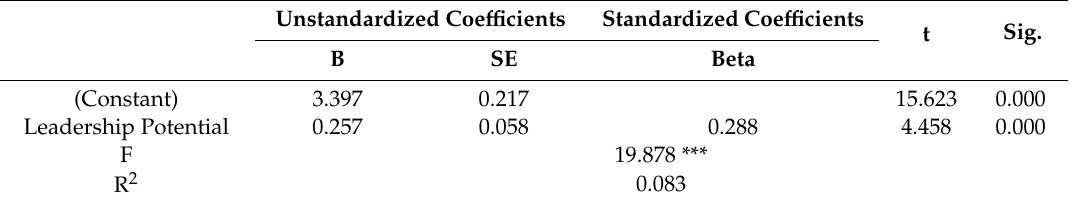
Table 5. Results for the e ff ect of leadership potential on leadership ostracism behavior.